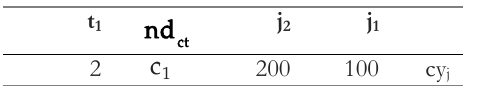
Table 2. Required relief personnel and injured people in need of service in each area.